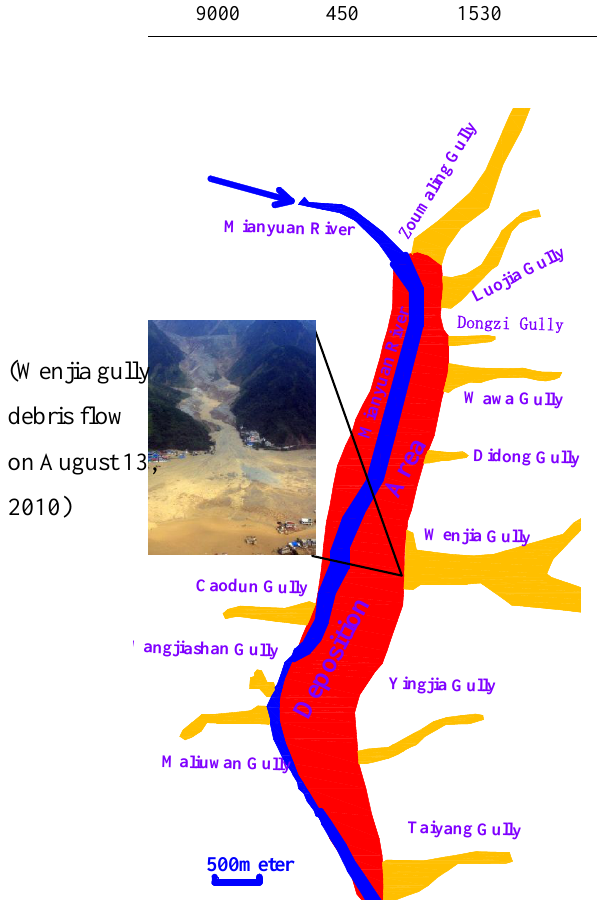
Figure 1. The geographic location of the study area Figure 2. Distribution of gullies in Qingping Fig. 2. Distribution of gullies in Qingping (Xu et al., 2012).